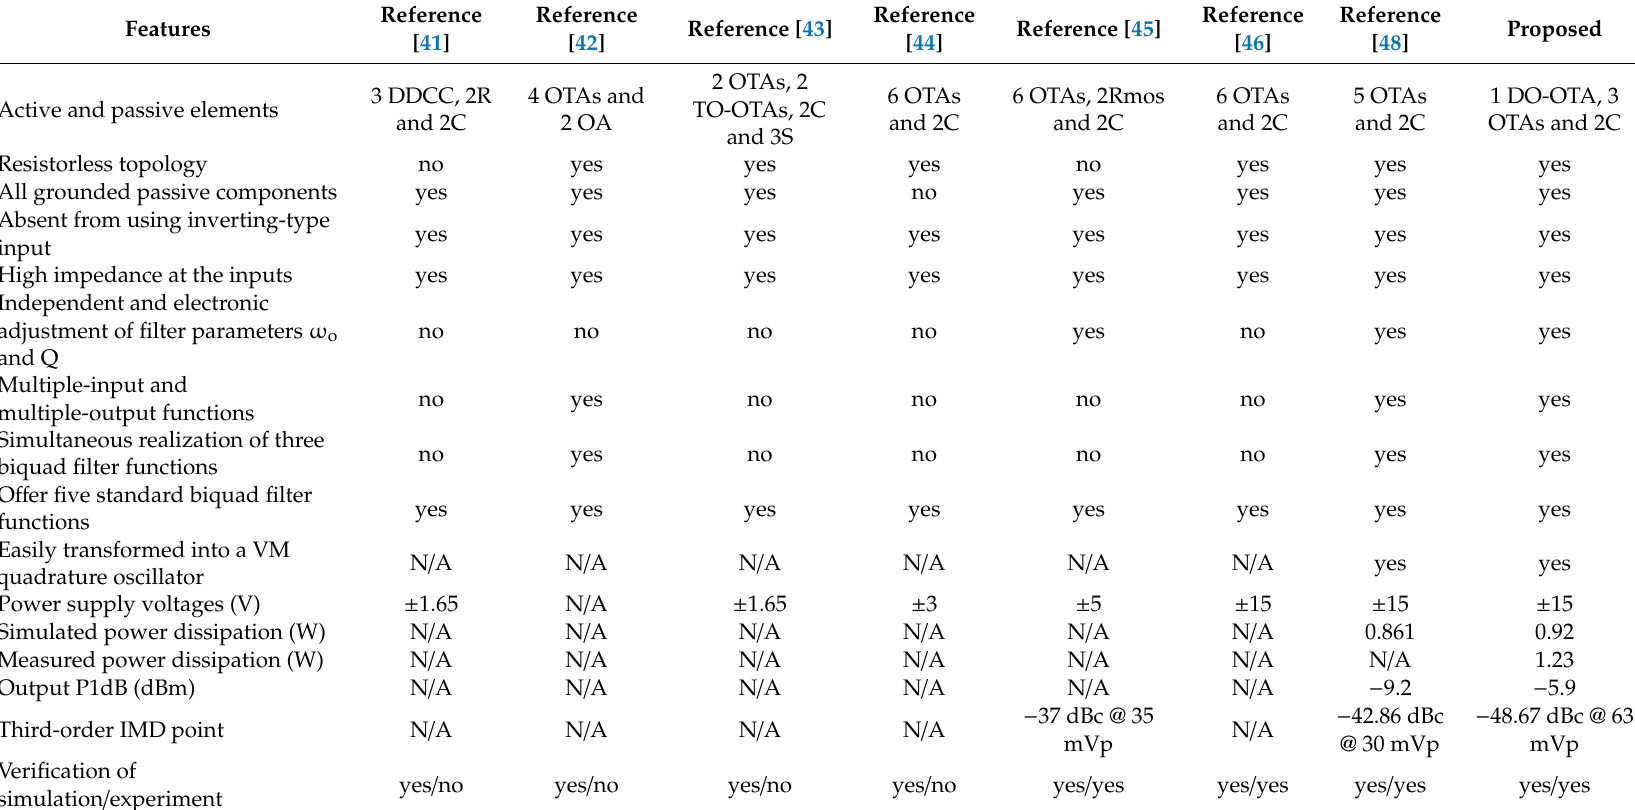
Table 1. Comparisons of the proposed versatile voltage-mode (VM) biquad filter with previous report